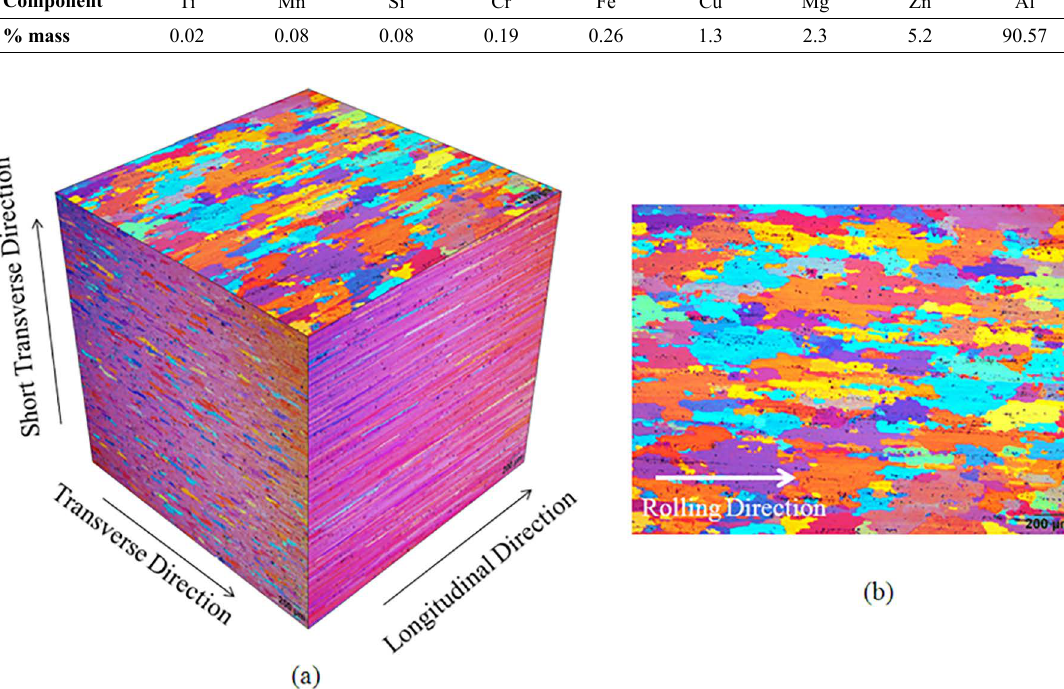
Figure 3. The observed particles are insoluble dispersoids formed by Cr, as indicated by the high Cr content found